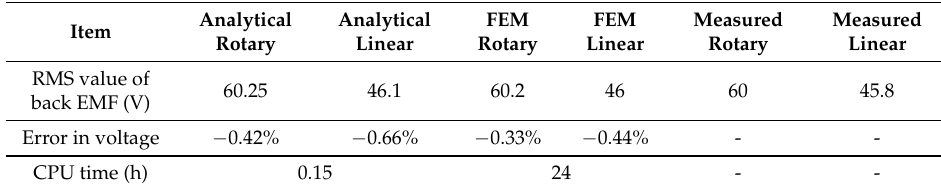
Table 2. Comparison of back EMF with experiment result.